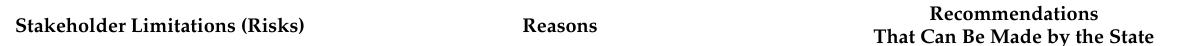
Table 6. Stakeholder risks and reasons for insufficient recycling of CFA. Recommendations for government agencies for the development of the CFA market. Source: designed by authors using [67,69,72]. Stakeholder Limitations